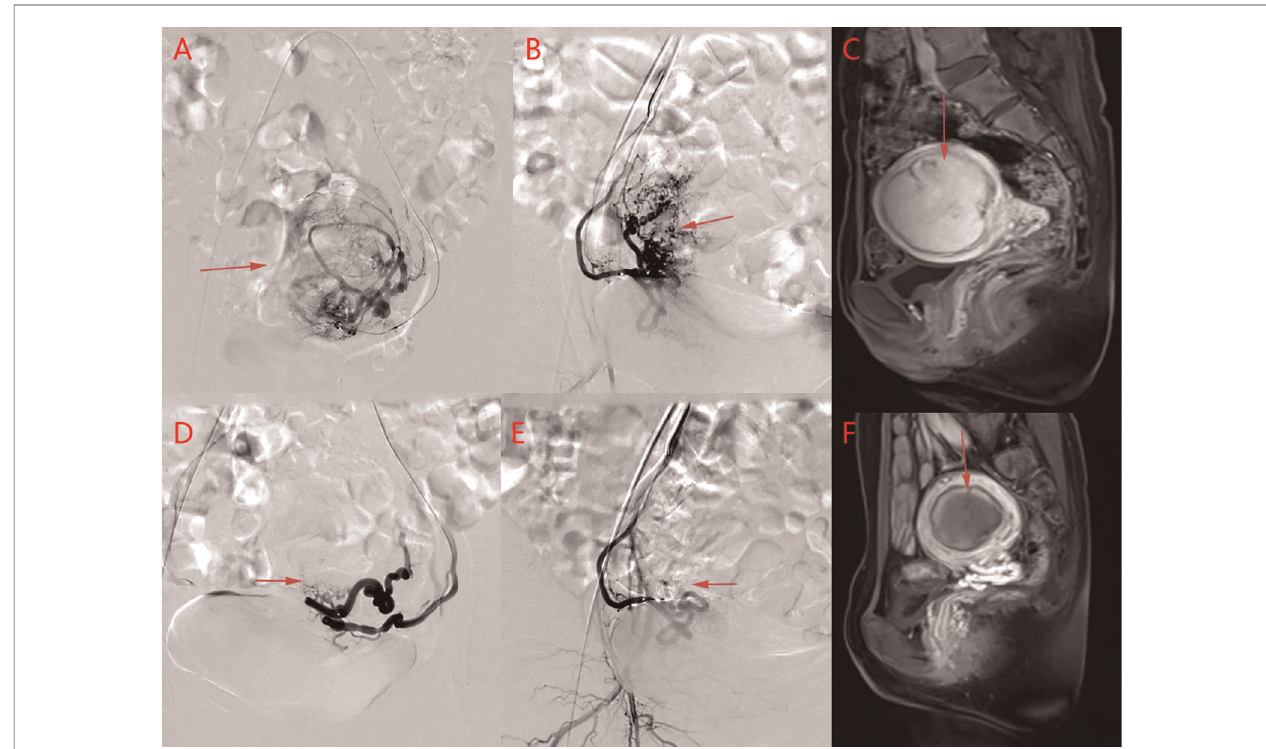
FIGURE 2 | An image from a patient in the control group. ( A ) Left uterine arteriography and ( B ) right uterine arteriography before uterine artery embolization. ( D ) Left uterine arteriography and ( E ) right uterine arteriography after uterine artery embolization. The bilateral leiomyoma arteries are basically occluded after embolization. ( C ) Before uterine artery embolization and ( F ) after uterine artery embolization. Pelvic MRI contrasts show that the volume of uterine leiomyoma has decreased from 5.1 cm×5.3 cm×7.9 cm to 3.3 cm×4.5 cm×6.1 cm, and the enhancement has disappeared, suggesting that the myoma is completely infarcted after uterine artery